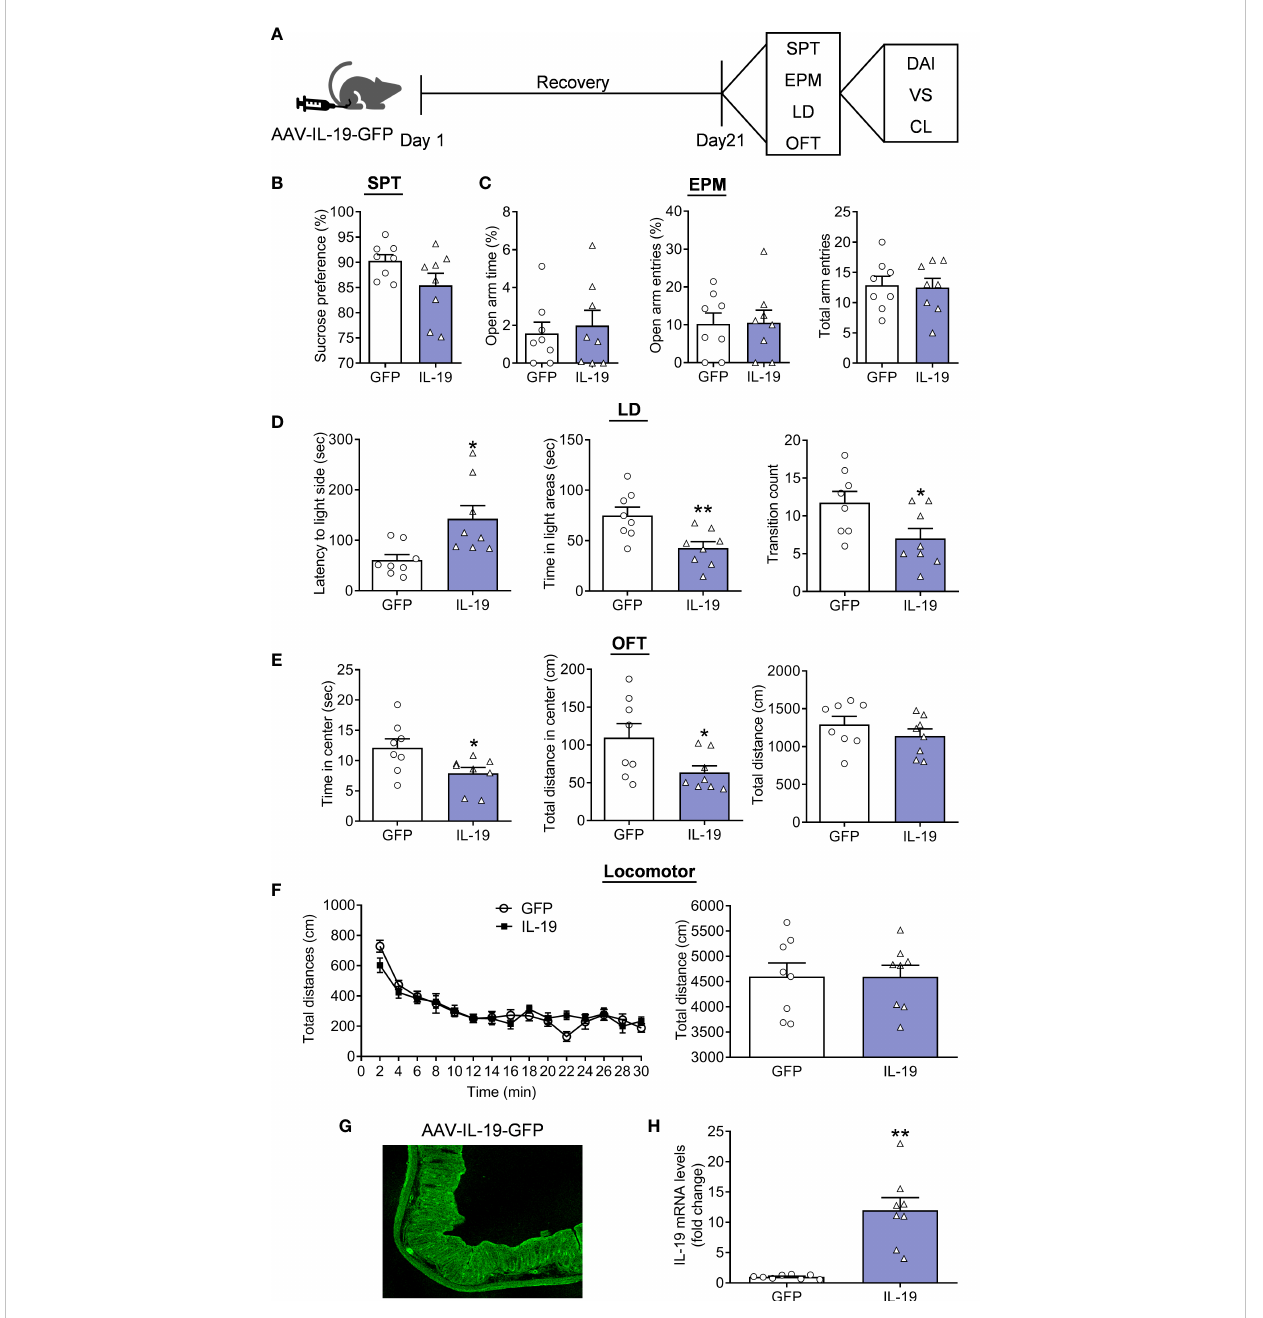
FIGURE 5 The effect of colonic IL-19 overexpression in depression/anxiety-related behaviors and colitis. (A) Schematic diagram of experimental designs. (B) Sucrose preference test (SPT). (C) Elevated plus-maze test (EPM). (D) Light-dark (LD). (E) Open- fi eld test (OFT). (F) Locomotor activity. (G) Representative image showing the expression of AAV-IL-19-GFP. (H) The IL-19 mRNA levels in the colon. GFP group: n=8, IL-19 group: n=8. * p < 0.05, ** p < 0.01, compared to the control